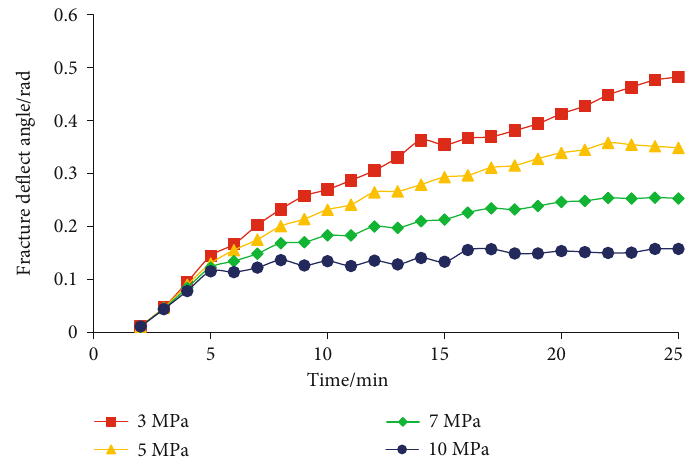
Figure 13: Variation in the de fl ection angle as a function of time under di ff erent stress di ff erences.